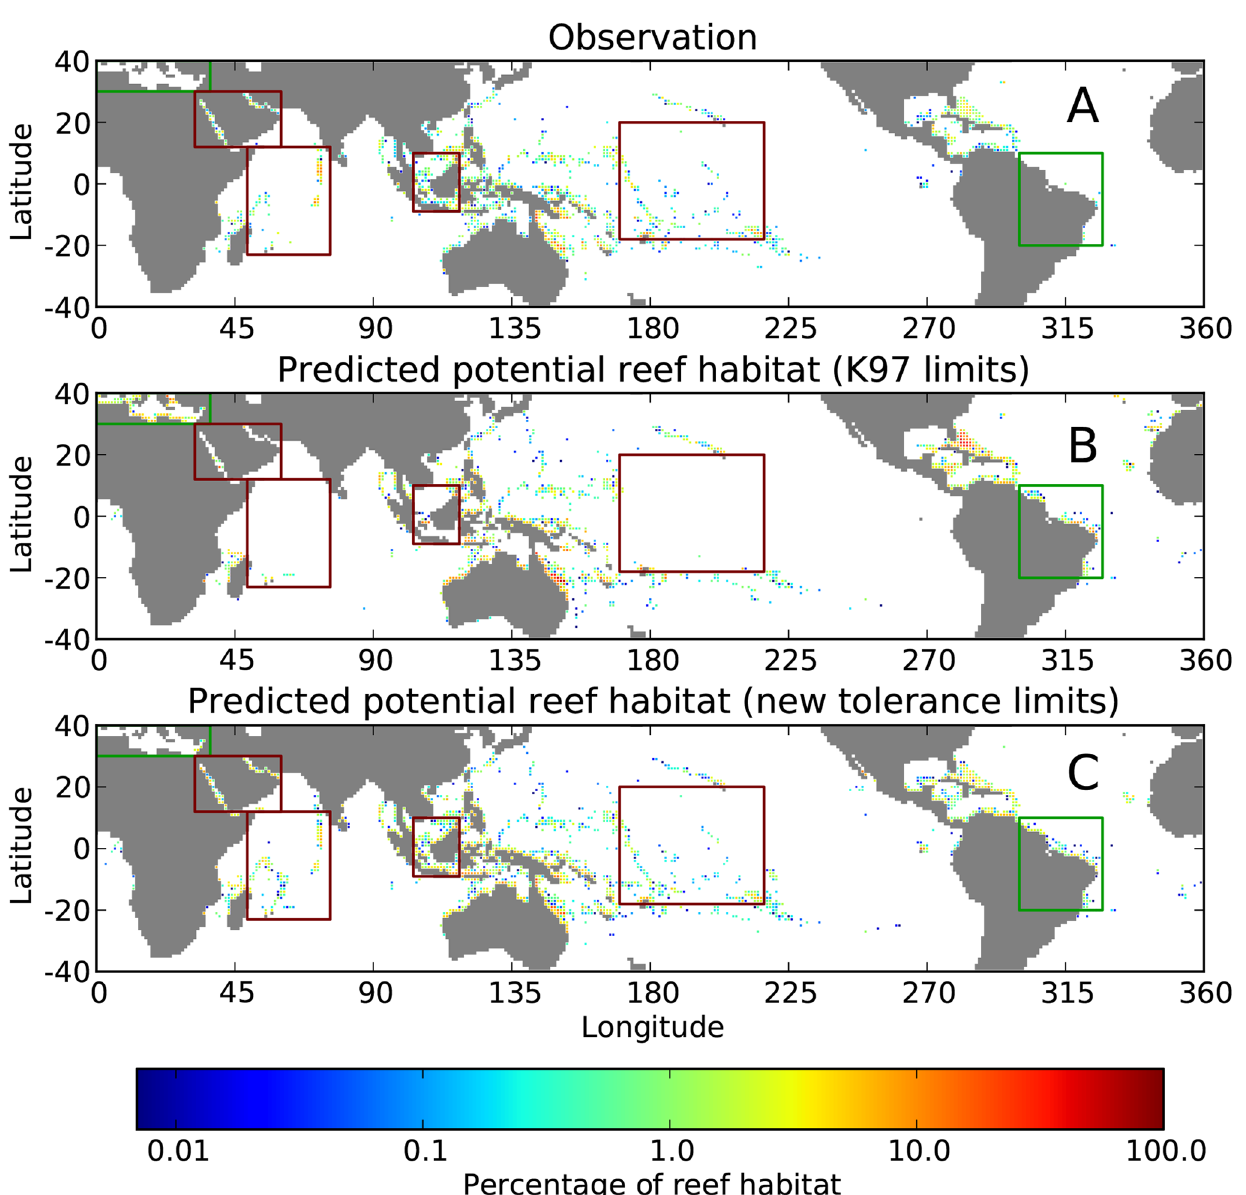
Fig 5. Observed coral reefs (A) and potential reef habitats predicted by ReefHab with the K97 tolerance limits (B) and with the tolerance limits derived in this study (C). All maps are presented on a 1° × 1° spatial resolution. Green rectangular boxes highlight areas where ReefHab overestimates the occurrences of potential reef habitats with respect to observations, whereas red boxes highlight areas where the occurrences of potential reef habitats are underestimated. The K97 tolerance limits fail to predict potential reef habitats in the Red Sea and Gulf of Aden, in the central Indian Ocean and central Pacific Ocean, and in the Indonesian Sea (B). These reefs are correctly captured by the new tolerance limits (C). The potential reef habitats predicted in the Mediterranean with the K97 limits are not produced with the new tolerance limits. Both tolerance limits predicted suitable potential reef habitats along the Brazilian coast, although the presence of reefs there is not confirmed by